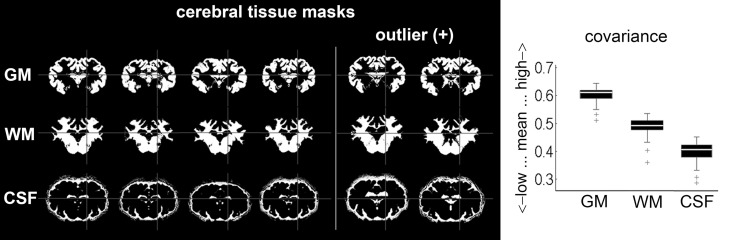
Mean covariance from automatically segmented tissue masks
(n = 38): six exemplary results (including the two only detected GM; WM and CSF outliers) after segmentation procedure with SPM. Outliers were subjected to careful visual inspection in order to identify potential non-cerebral tissue adnexae, but no mask was excluded according to pre-set criteria (no significant misclassifications). GM, gray matter; WM, white matter; CSF, cerebrospinal fluid.